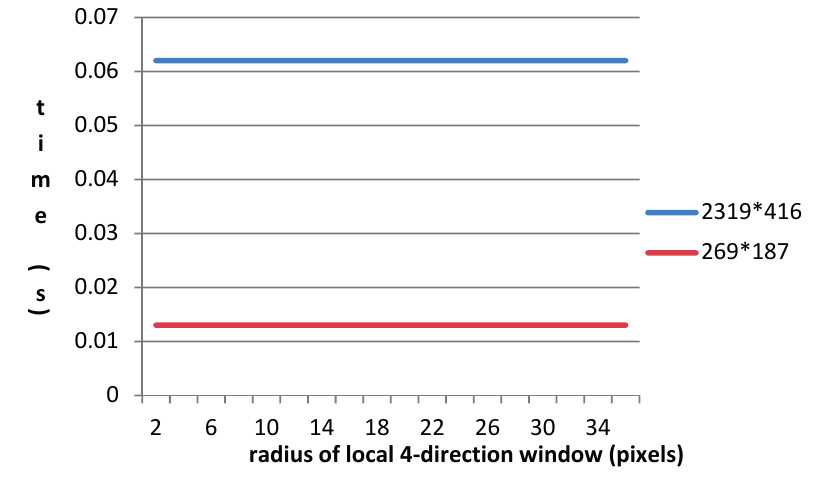
Figure 9. Relationship between the radius of local window and time of the detection